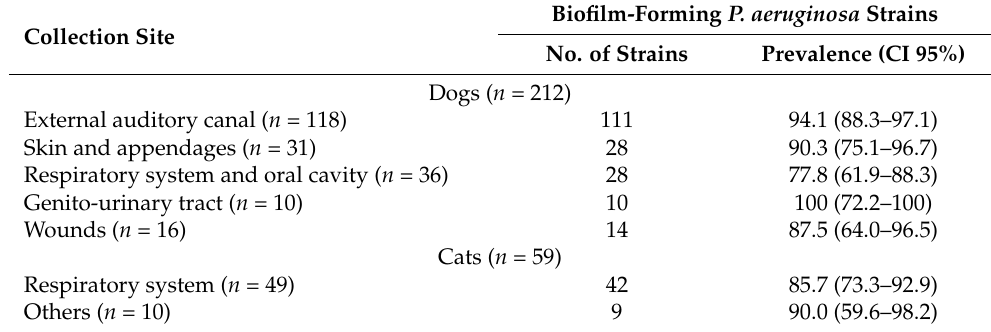
Table 3. Biofilm-forming Pseudomonas aeruginosa strains isolated from various collection